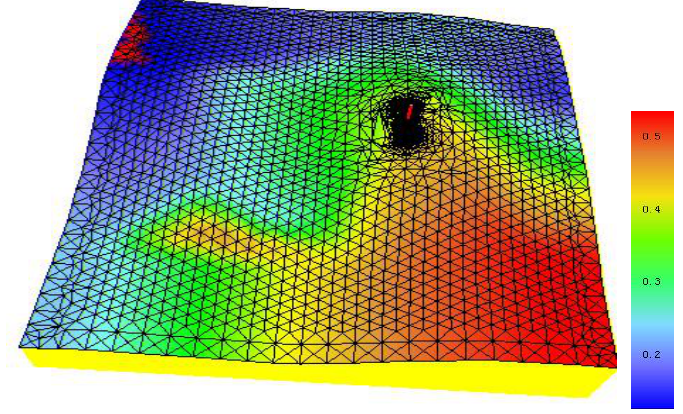
Figure 9—Numerical model of permeability distribution of SuA-B-CH2